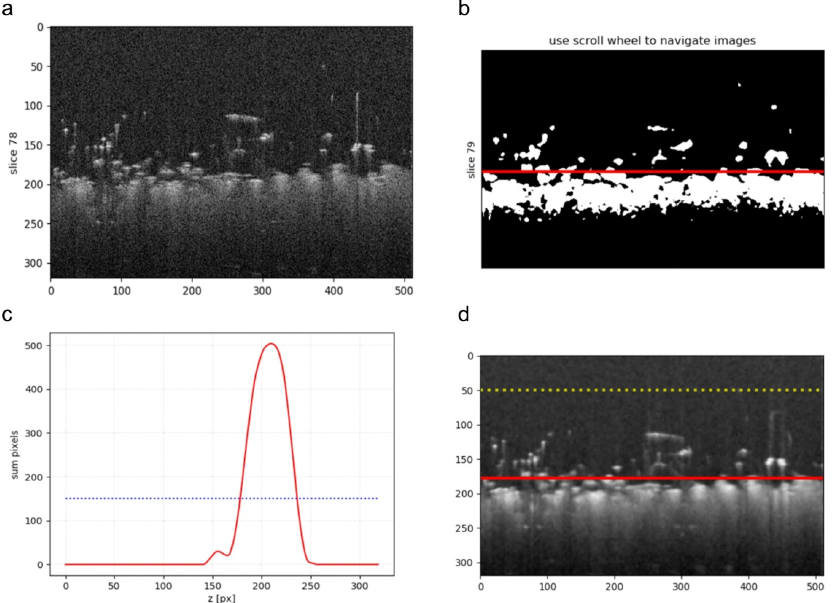
Figure 5. Illustration of pilling layer extraction steps for a knitwear B-scan: ( a ) example B-scan image; ( b ) the image from figure (a) binarized using the Otsu method with the detected knitwear surface line; ( c ) the horizontal Hough transform H ( z ) of the binary image in figure (b) with the line of the material surface detection level k · H ( z 0 ) (Equation (6)); ( d ) the image from figure (a) with the pilling layer detected between horizontal